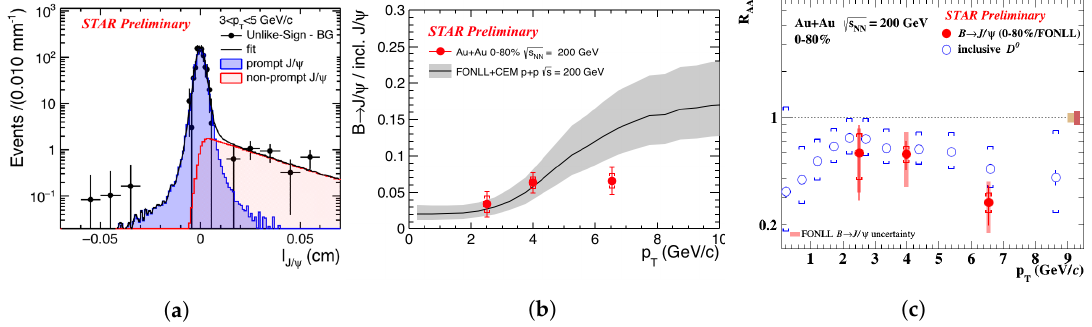
Figure 2. ( a ) l J / ψ distribution for inclusive J / ψ fitted with templates for non-prompt and prompt J / ψ . ( b ) fraction of non-prompt J / ψ as a function of p T . ( c ) R AA of non-prompt J / ψ as a function of p T compared with that of D 0